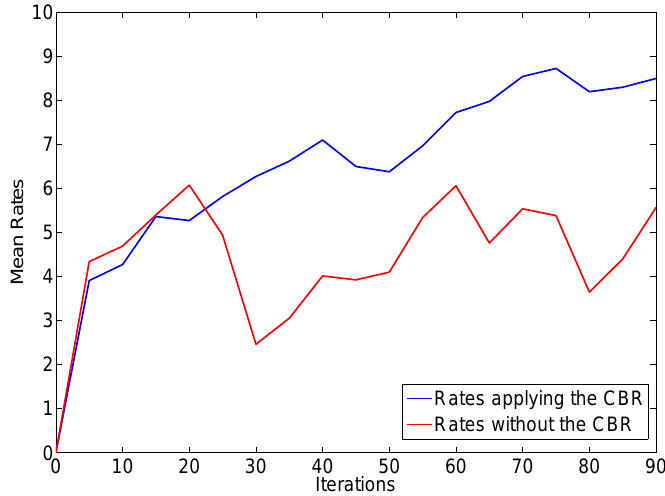
Figure 8. Evaluation of results in two different situations, with and without the CBR